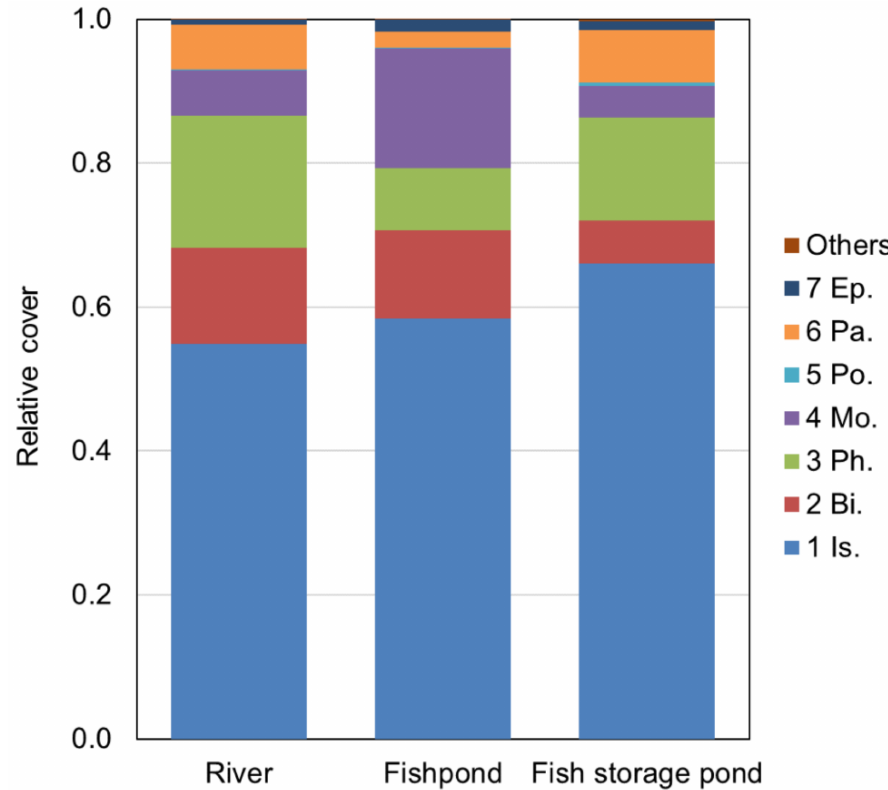
Figure 7. Relative cover (average of three 1 m 2 plots) of species groups according to vegetation classes (see Figure 6) in the three habitat types, rivers ( n = 11), fishponds ( n = 10), and fish storage ponds ( n =